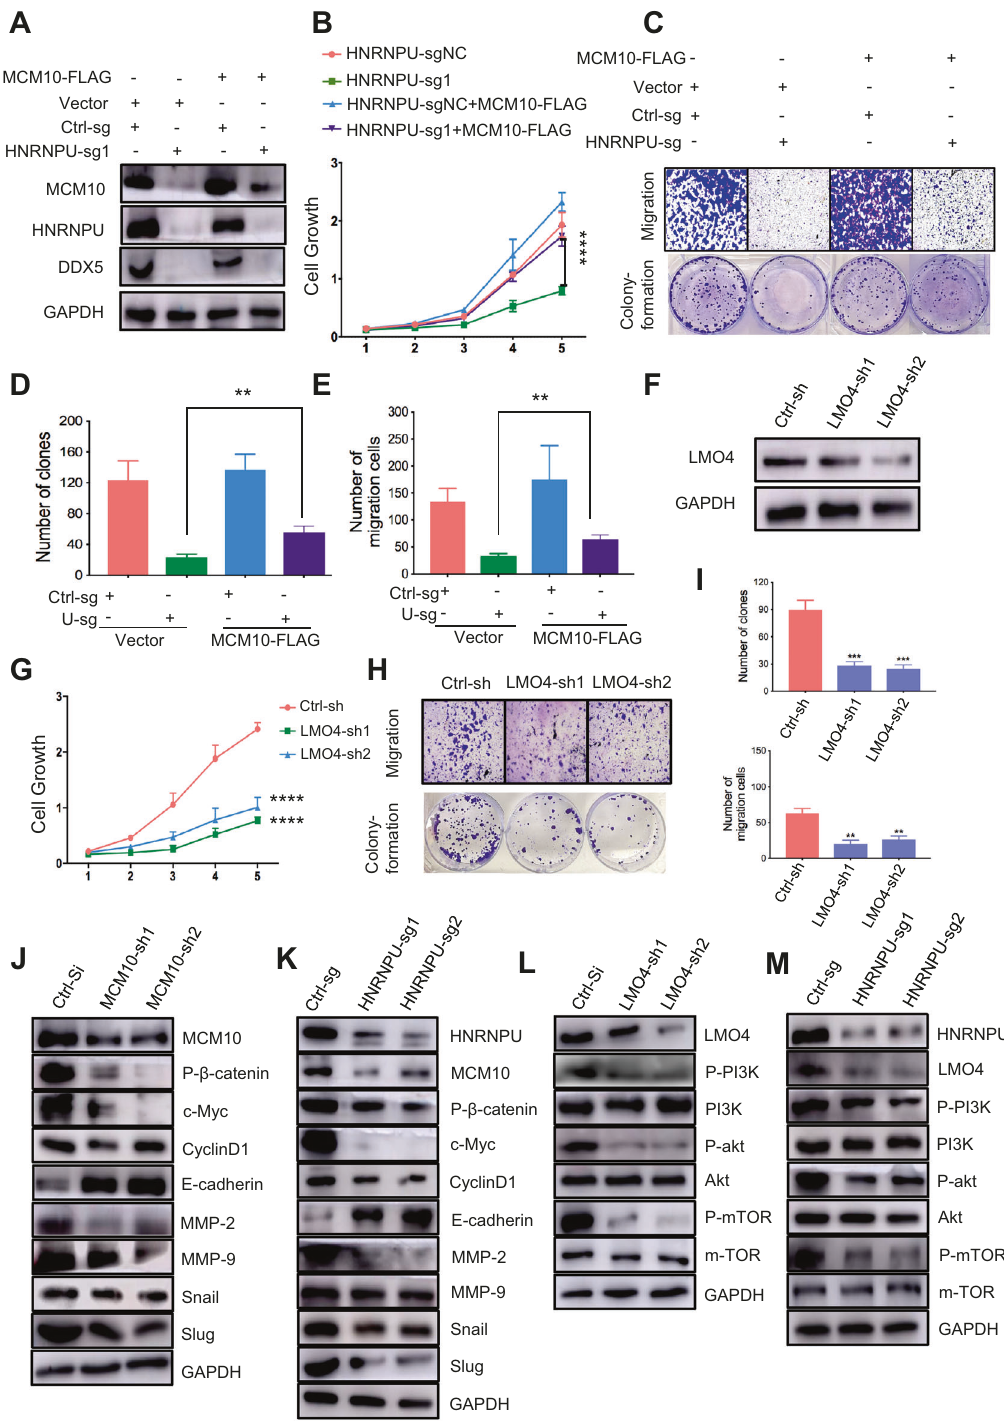
Fig. 6 HNRNPU activates the Wnt/ β -Catenin pathway and PI3K/Akt/mTOR pathway by regulating MCM10 and LMO4. A Western blot analysis of endogenous HNRNPU knockout MCF10 CA1a cells stably expressing exogenous MCM10-FLAG. B Cell proliferation assays of the cells described in Fig. 6A. C – E Colony formation assays and Transwell assays of the cells described in Fig. 6A. Representative images ( C ) and quantitative results ( D , E ) are shown. F MCF10 CA1a cells were transfected with two different shRNAs targeting LMO4 (LMO4-sh1, LMO4-sh2) or negative control shRNA (Ctrl-sh). Cells were analysed by immunoblotting after 48 h of transfection. G Cell proliferation assays of the cells described in Fig. 6F. H , I Colony formation assays and Transwell assays of the cells described in Fig. 6F. Representative images ( H ) and quantitative results ( I ) are shown. Data were presented as the mean ±SEM. *** p <0.001, ** p < 0.01, * p <0.05, n.s. not signi fi cant. J Western blot analysis showing the levels of P- β -catenin, c-Myc, CyclinD1, E-cadherin, MMP-2, MMP-9, Snail and Slug when the expression of MCM10 was decreased. K Western blot analysis showing the levels of MCM10, P- β -catenin, c-Myc, CyclinD1, E-cadherin, MMP-2, MMP-9, Snail and Slug when the expression of HNRNPU was decreased. L Western blot analysis shows the levels of P-PI3K, PI3K, P-akt, Akt, P-mTOR and mTOR when the expression of LMO4 was decreased. M Western blot analysis shows the levels of LMO4, P-PI3K, PI3K, P-akt, Akt, P-mTOR and mTOR when the expression of HNRNPU was